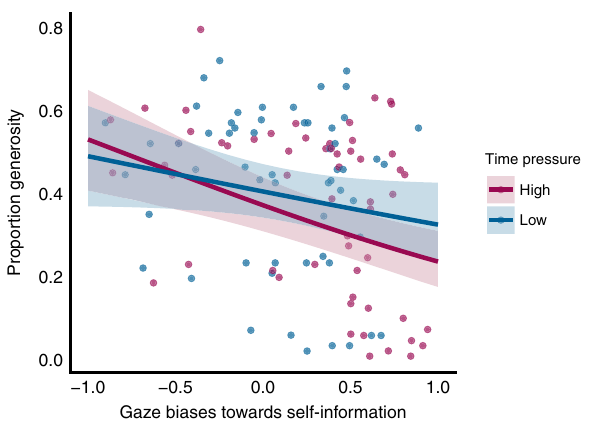
Fig. 4 Time pressure moderates gaze-biases ’ effects on generosity. Each point represents a single subject ( N = 57), coloured by time pressure condition. Solid lines represent the predicted group averages extracted from the general linear model. Shaded regions represent the 95% con fi dence interval of the predicted values centred at the predicted group mean, coloured by time pressure condition. Source data are provided as a Source Data fi